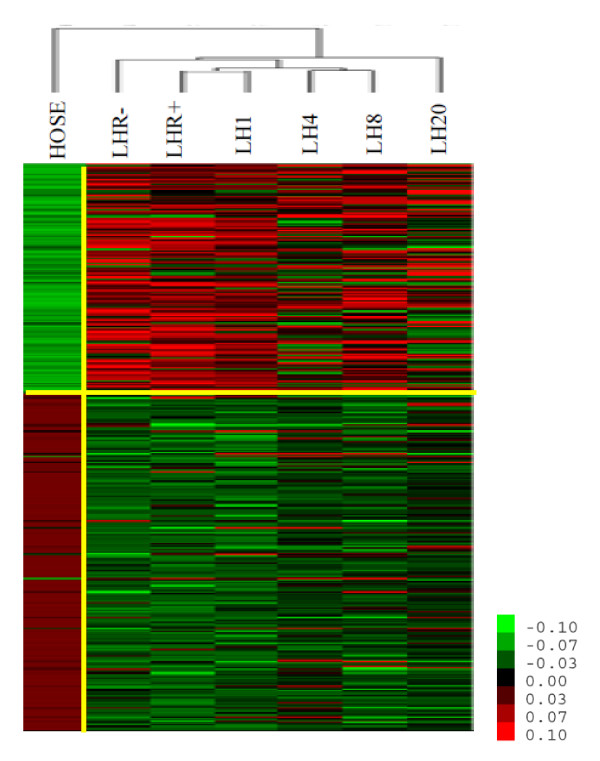
A heatmap of the 185 and 248 genes, up-regulated and down-regulated, respectively, in normal HOSE versus SKOV-3 cells: control (LHR-) and LHR+ receiving no LH (LHR+) and following incubation with LH for 1, 4, 8, and 20 h.